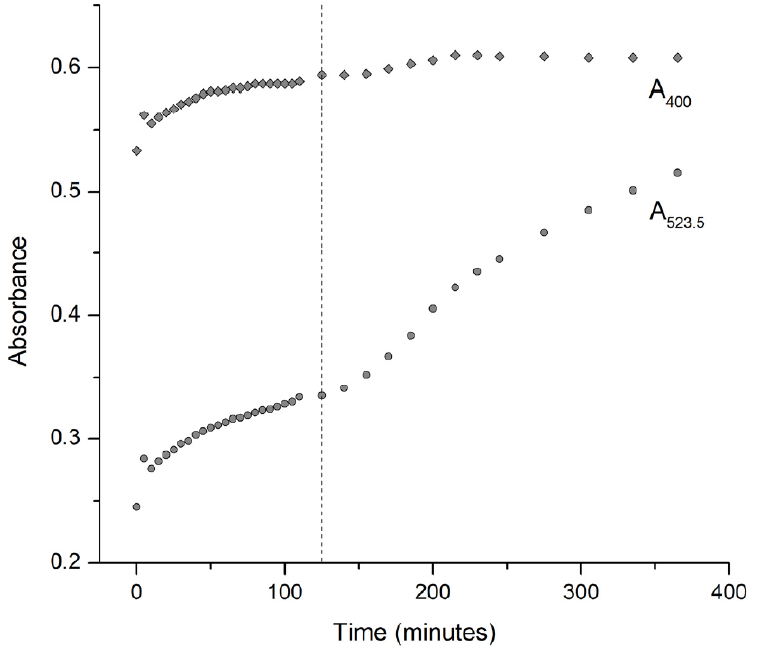
Figure 2. The kinetic curves plotted for two positions in the UV–VIS spectrum: absorbance at 400 nm (Au 0 ) and at 532.5 nm (spheres >2 nm in diameter). The dashed line refers to the seed overgrowth at 125 min after the reaction